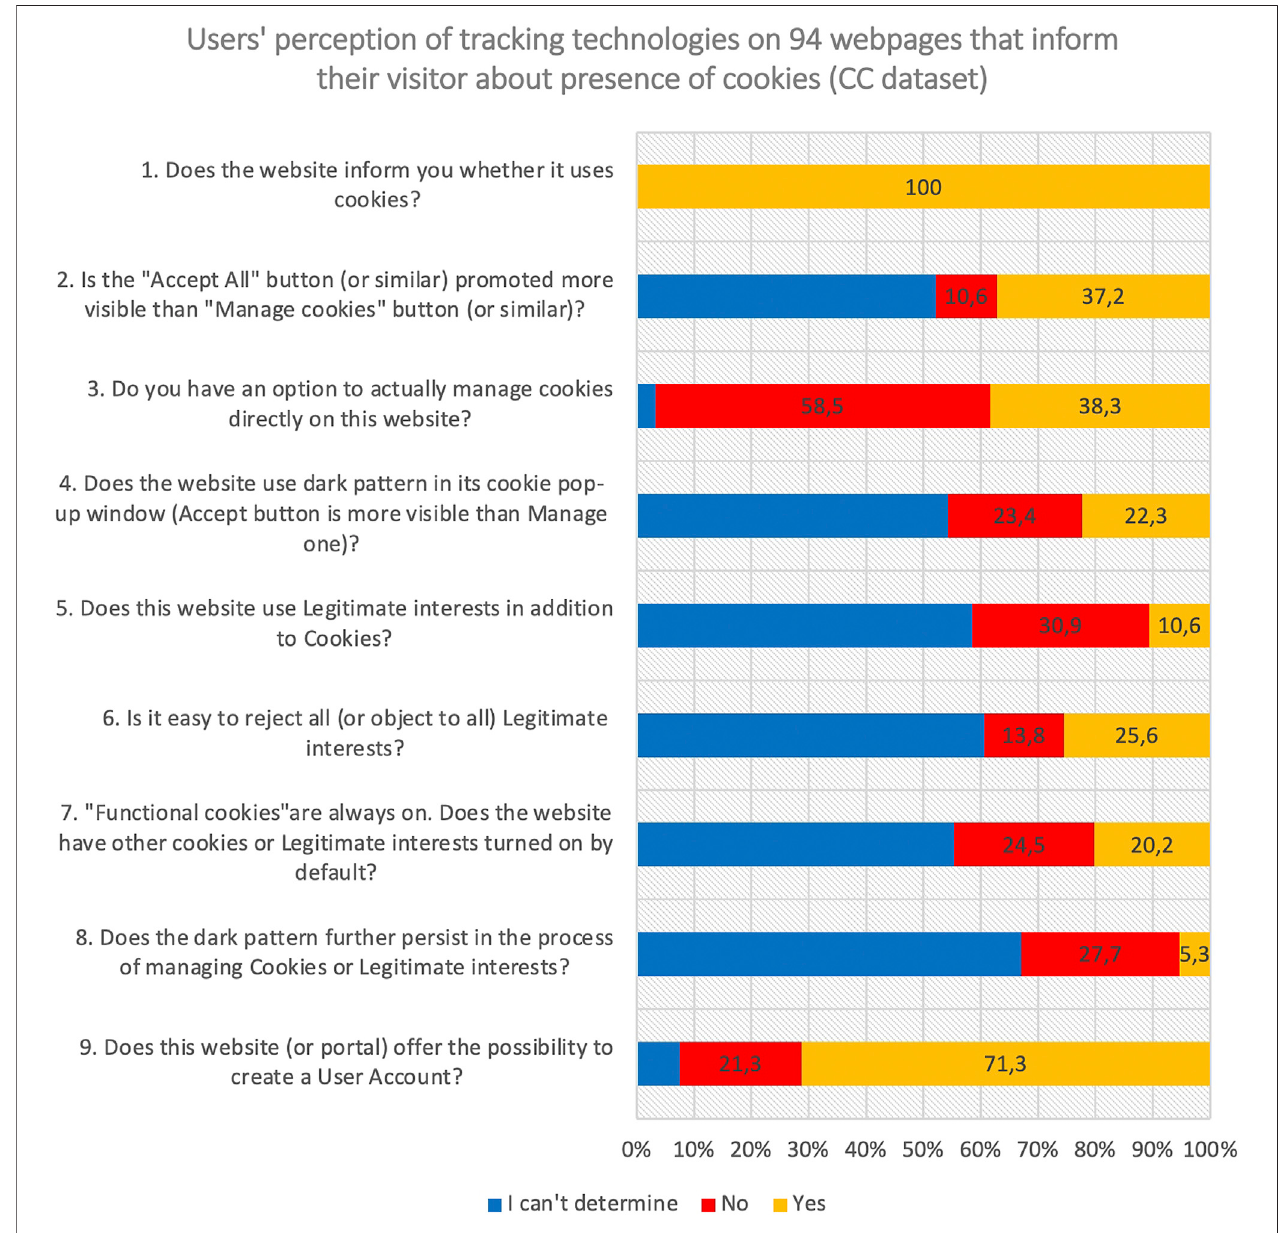
FIGURE 1 | User´s perception of tracking technologies on the subset CC described in the text.